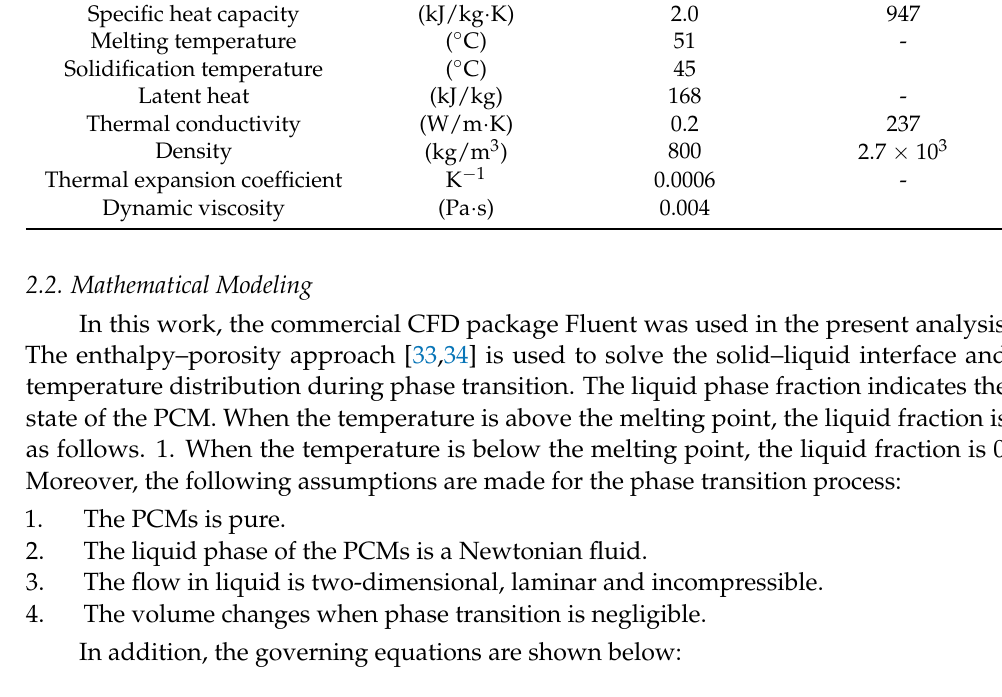
Figure 1. Model of LHTES unit with bifurcated fins. Table 1. Thermal parameters of paraffin and aluminum.